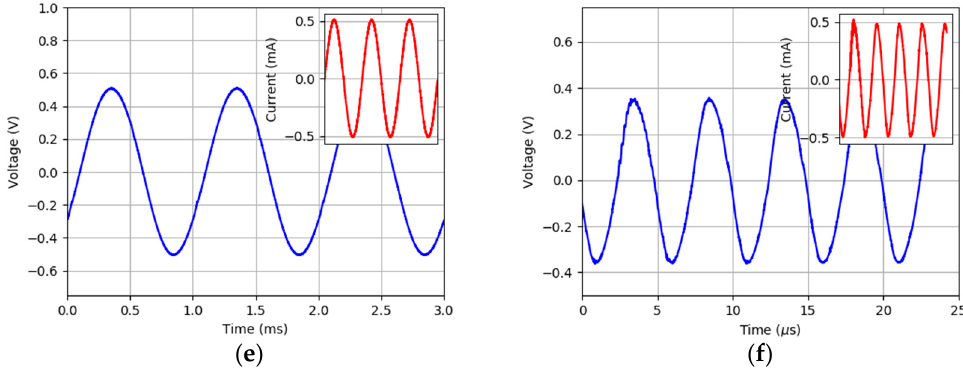
Figure 14. Stimulation waveforms as delivered on electrodes in a saline solution. Currents are recorded during the stimulation with a transimpedance amplifier; voltages are recorded on the electrode. All currents are plotted in red in insets; all voltages are plotted in blue. Insets have the same time windows as their parent plot. ( a ) Typical burst of biphasic pulses ( Tc = 30 µs, inter-pulse of 10 µs, active balancing with a current ratio of 1:2, stimulation frequency of 8kHz) applied on a LIFE electrode. ( b ) Temporal zoom on the same stimulus as (c). ( c ) Slowly rising pulse as performed in [23] for improved selectivity stimulation. The amplitude is 500 µA, the waveform has been balanced with a constant current anodic pulse. The waveform has been applied on a CUFF electrode. ( d ) Biphasic pulse with pre-pulse addition as described in [22] for cell-type selectivity. The waveform has been applied on a TIME electrode. ( e ) Sinusoidal waveform corresponding to High-Frequency Blocking Stimulation as performed in [26] with a frequency of 1 kHz and an amplitude of 500 µA applied on a CUFF electrode. ( f ) Sinusoidal waveform with a frequency of 200 kHz and an amplitude of 500 µA applied on a CUFF electrode.